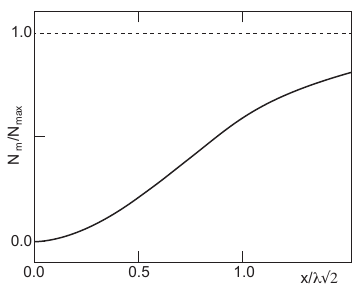
√ 2 λ α . The Figure 2. The Landau–Ginzburg parameter κ ρ /κ ρ, sat as a func- tion of the anisotropy ratio τ = T (cid:107) /T ⊥ < 1 for the particular choice τ sat = 1 . The parameter κ ρ refers to the thermal gyroradius as the 4 short-scale correlation length, as explained in the text. It maximizes at saturation anisotropy τ = τ sat and vanishes for τ = 1 when no instability sets in. For any given ratio τ the value of κ ρ lies on a curve like the one shown. There is a threshold for the mirror mode to evolve into bubbles which it must overcome. It is given by the ra- tio κ ρ, sat > 1 of the critical Alfvén speed to perpendicular thermal